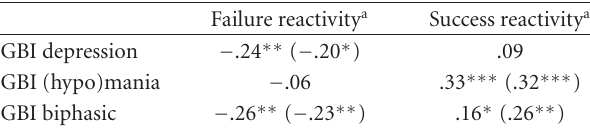
GBI: general behavior inventory; values between brackets are partial correlations between variables controlled for current manic (ASRM) and depression (DASS-D) symptoms; n varies because of missing data. a Higher scores on the reactivity scales reflect higher levels of